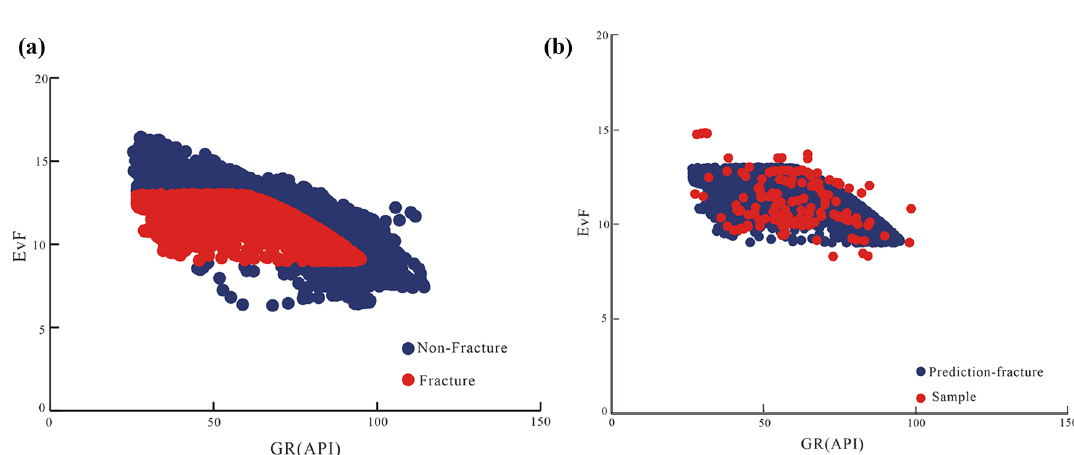
Figure 14. The predicting fracture development data points by EvF are consistent with the data points of fracture